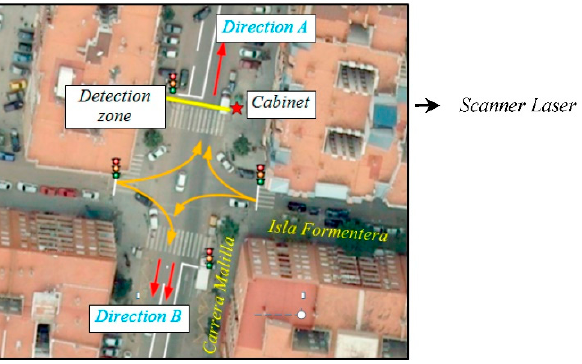
Figure 11. Intersection under study.